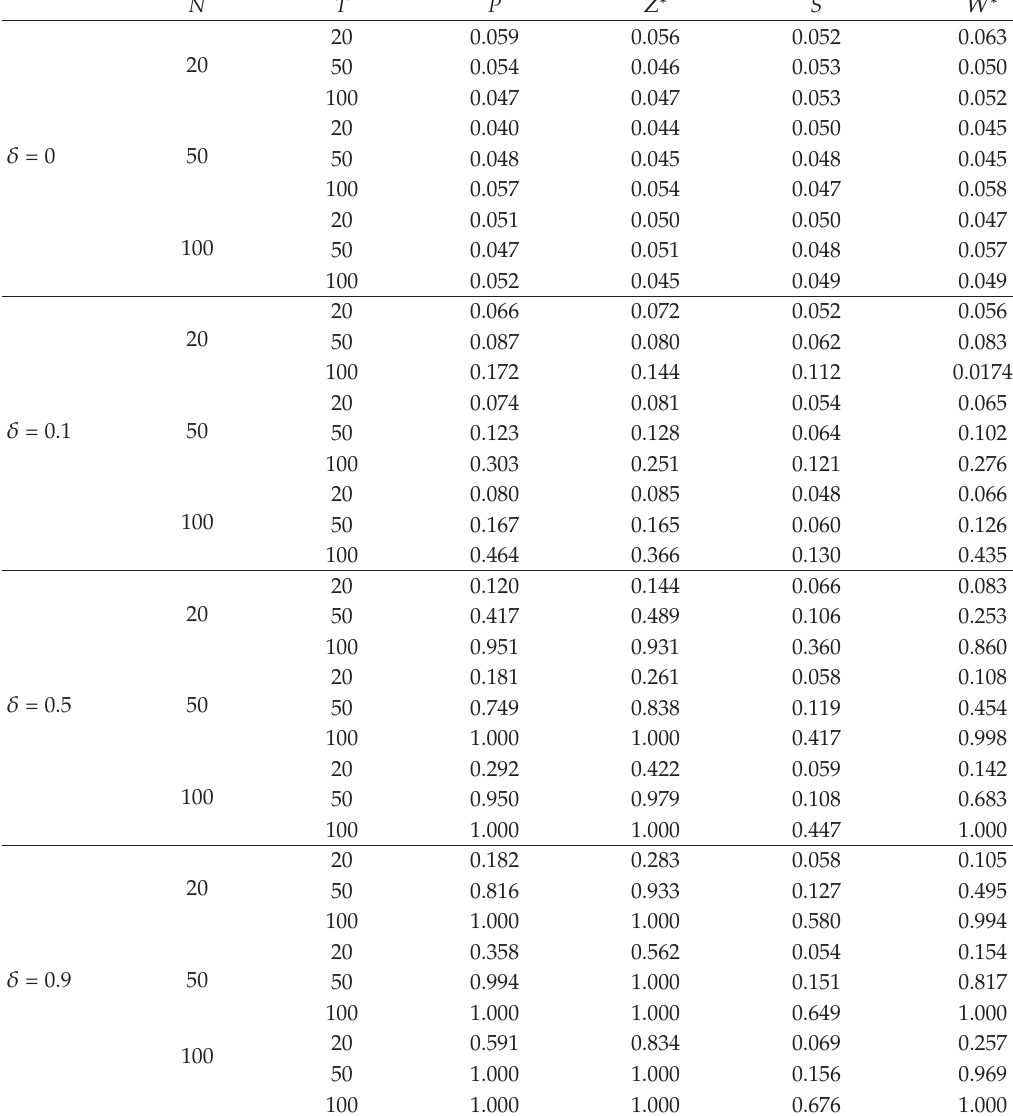
Table 1: Size and power of panel unit root tests: cross-section